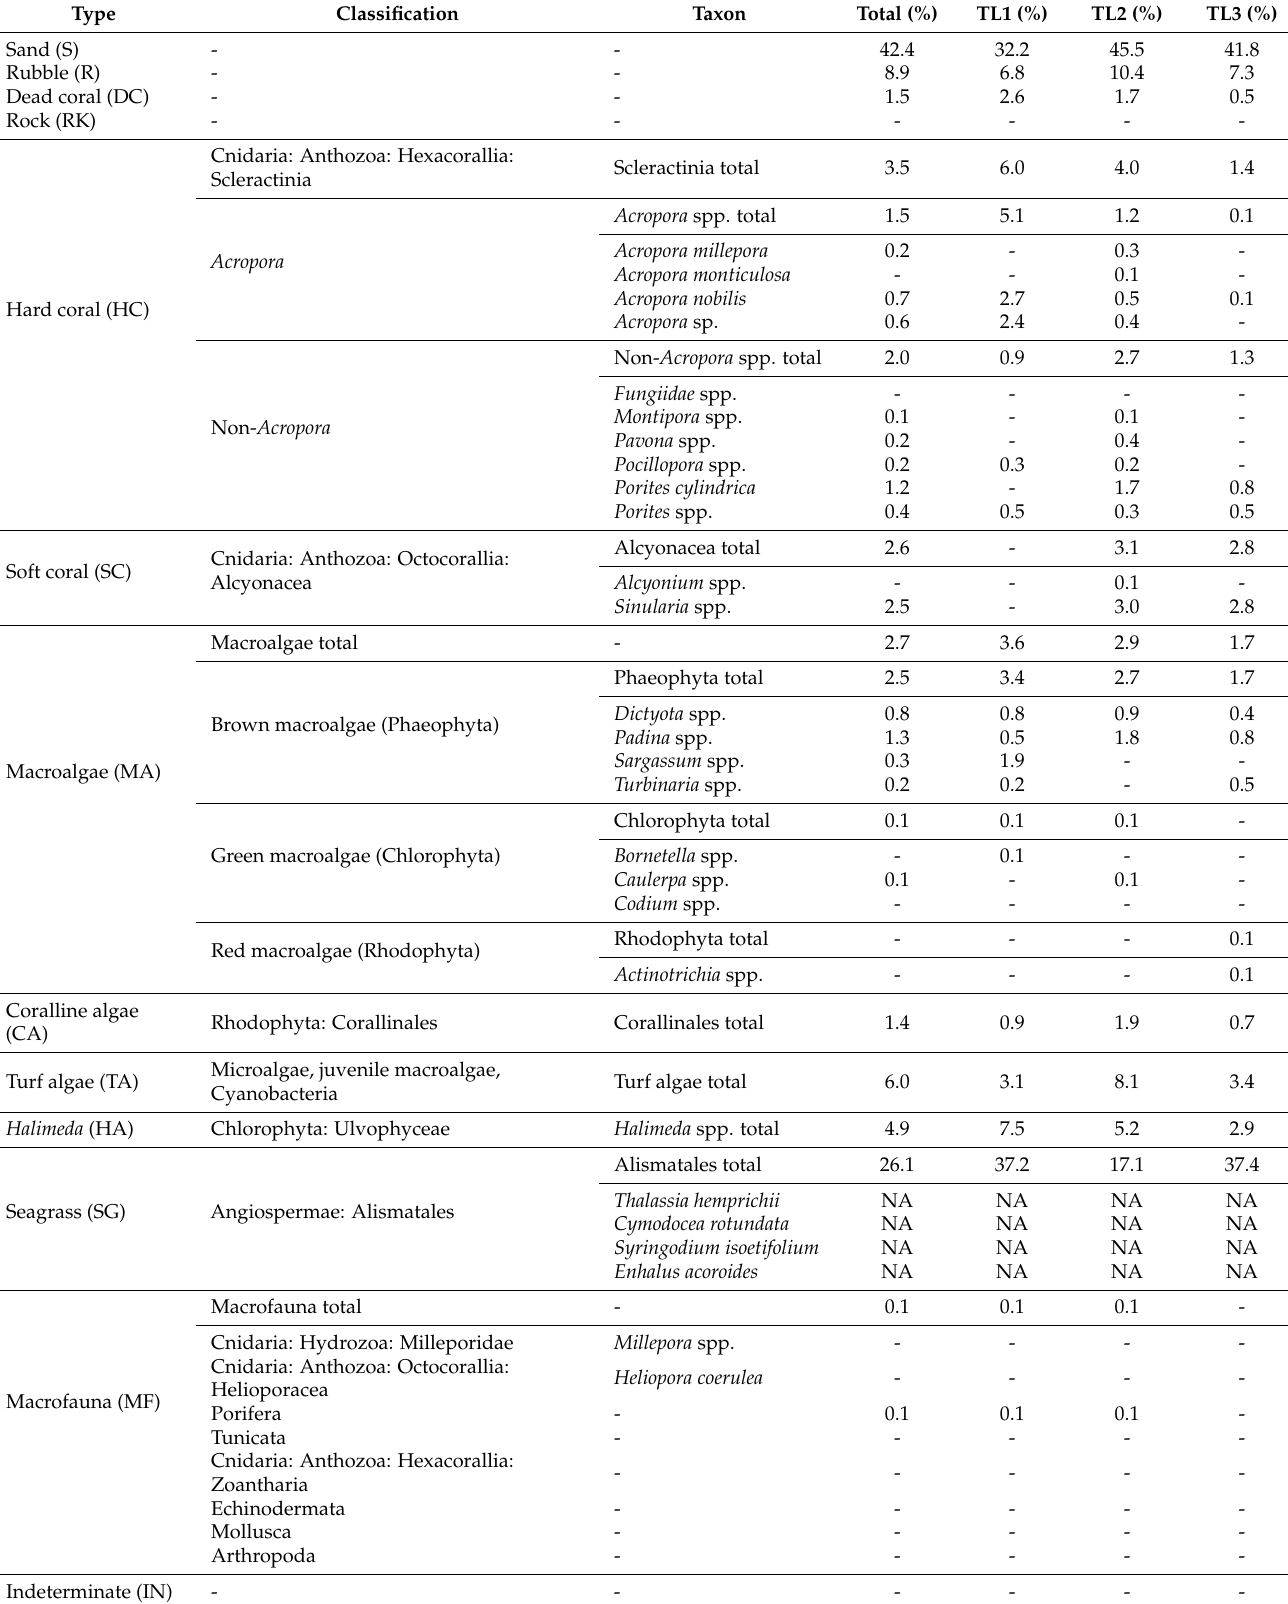
Table 2. Relative coverage (%) by benthic habitat types along the three transect